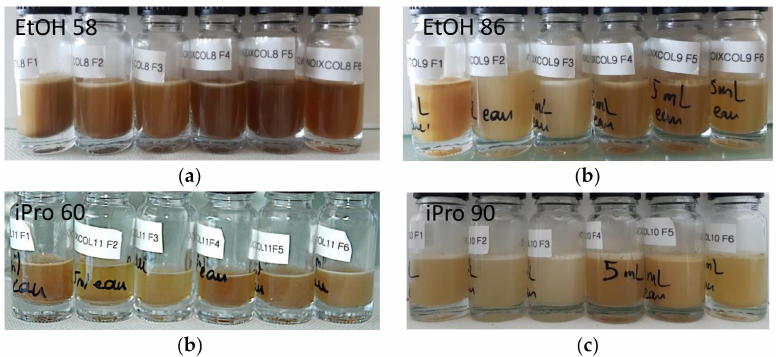
Figure 6. Aqueous dispersions obtained by hydrating the dried fractions collected during extraction with ( a ) EtOH 58, ( b ) EtOH 86, ( c ) iPro 60, ( d ) iPro